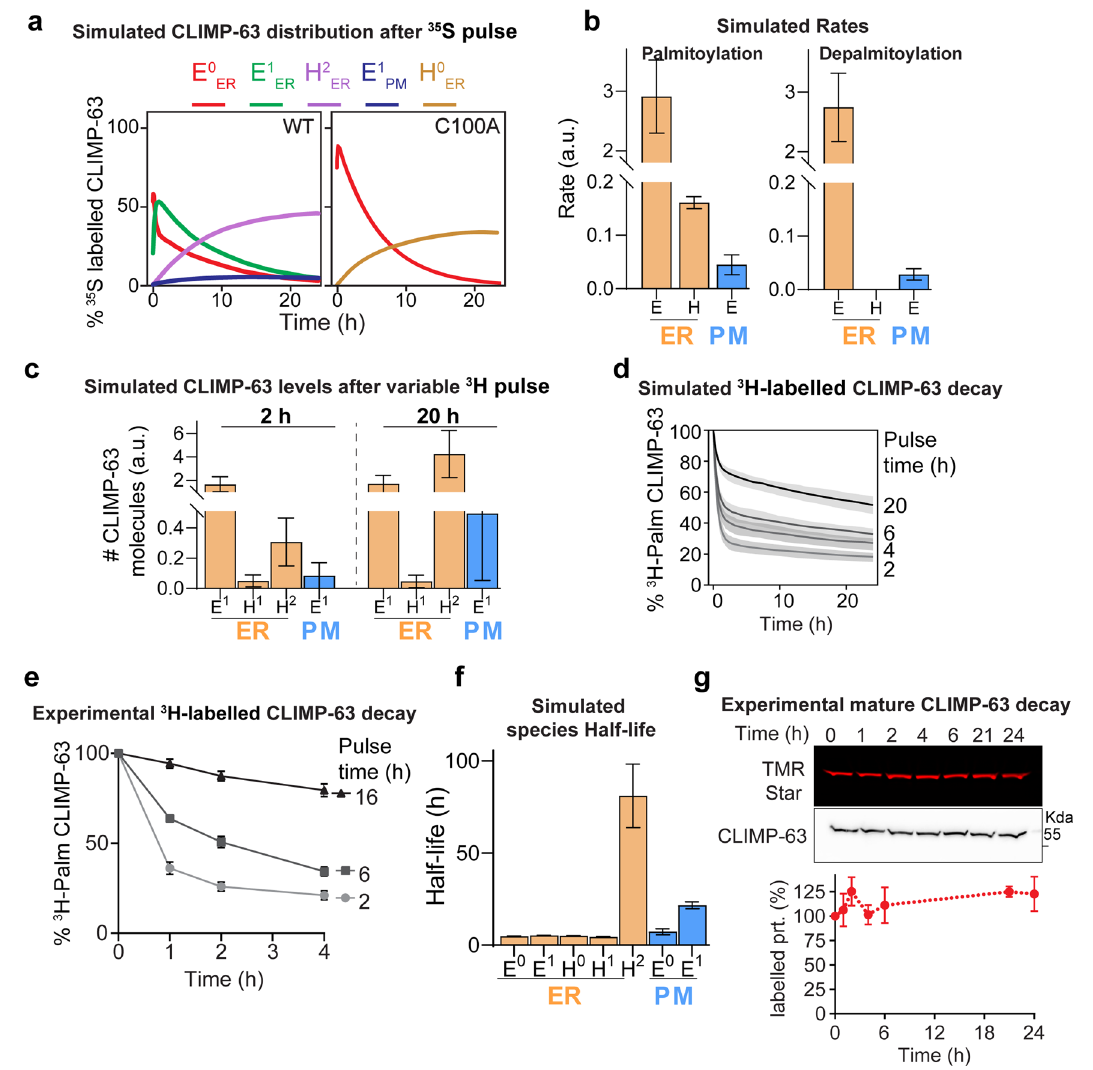
Fig. 5 | Validation of CLIMP-63 palmitoylation modelling. a Simulation of the levels of differently labelled CLIMP-63 species throughout time during a 35 S-Cys/ Met pulse-chase experiment. b Predicted palmitoylation and depalmitoylation rates for different CLIMP-63 species (ER-yellow, PM-blue). Rate for H species cor- respond to its sum in the ER (H0+H1for Palmitoylation and H2+H1 for Depalmi- toylation). c , d SimulationofthelevelsoflabelledCLIMP-63aftertheindicated3H- palmitate pulse period. d Evolution of labelled CLIMP-63 after the indicated H-palmitatepulseperiods. e Experimentalpulse-chaseexperimentaftereither2,6, or 16h of metabolic labelling with 3H-palmitate. Values were normalized to the